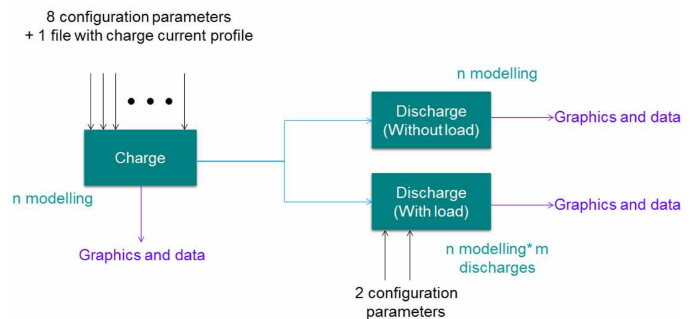
Figure 6. Model architecture represented as a block diagram, including the program inputs and outputs.